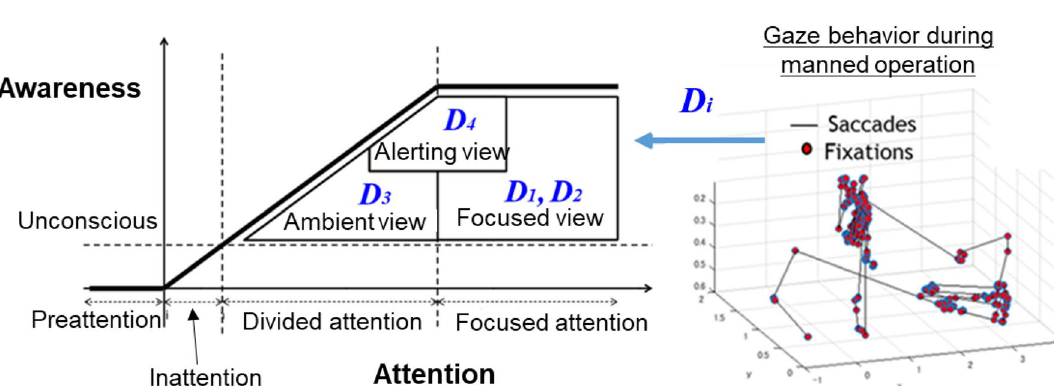
Figure 5. The HMI elements are developed according to the attention-awareness model 3,7 , but the method is extended by defining adaptive views emprically using gaze fixations of manned